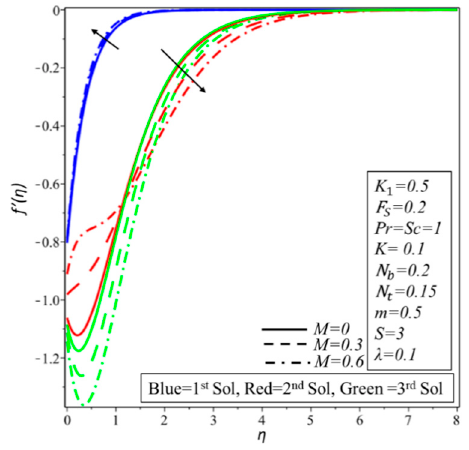
Figure 5. Profiles of the velocity for increasing values of M .